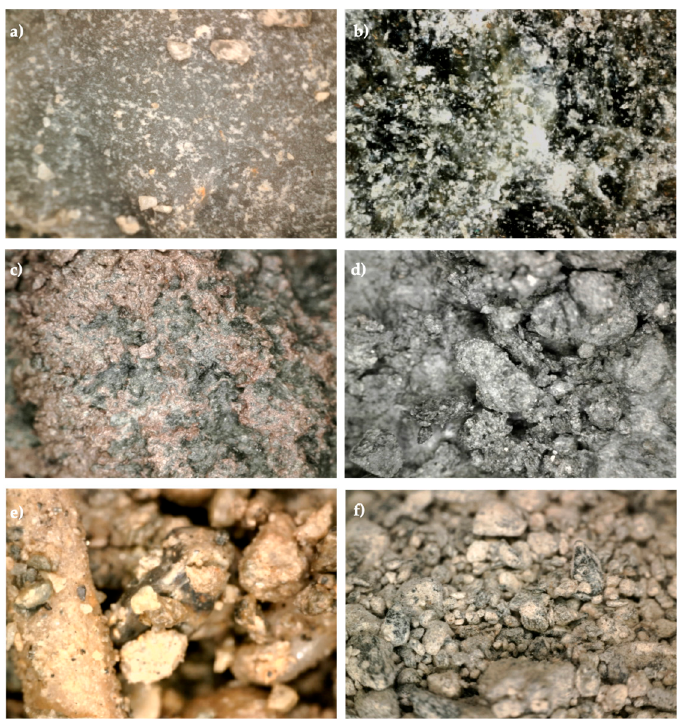
Figure 3. Stereoscopic micrographs (80 × magnification) of: ( a ) meta-argillites; ( b ) serpentinite; ( c ) metabasalts; ( d ) calc-schists; ( e ) debris and ( f ) soil.